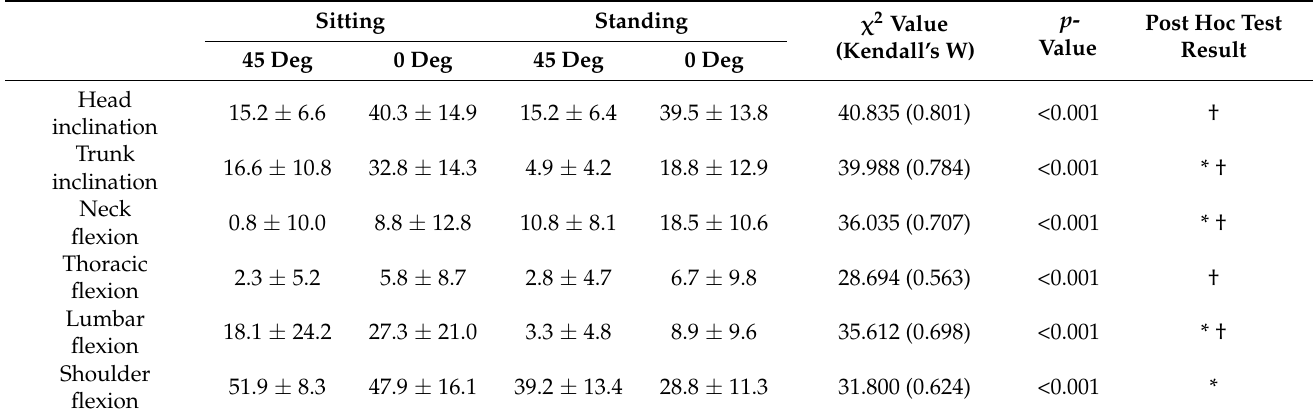
Table 2. Mean segment and joint angles (deg) during the task for each experimental condition. Sitting